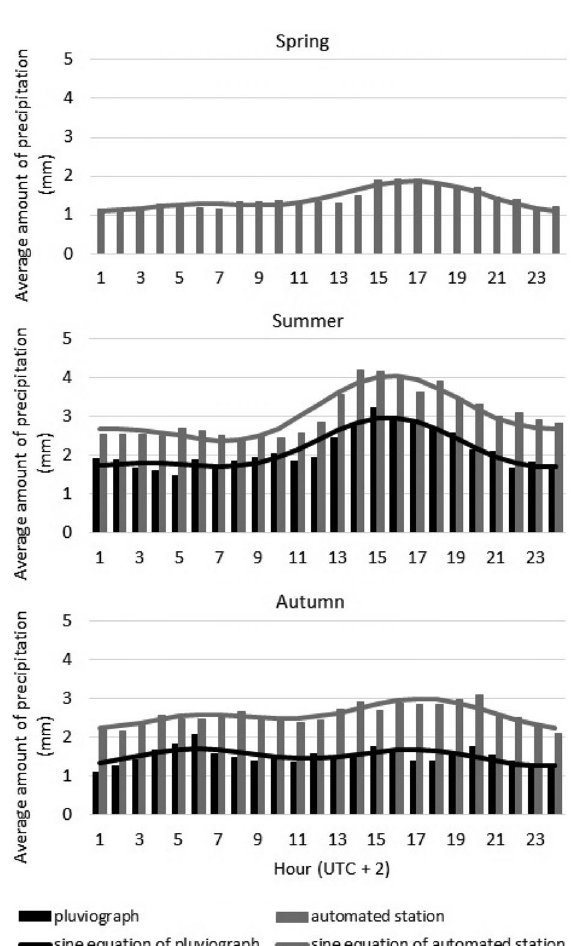
Fig. 3. Mean diurnal distribution of hourly precipitation amounts (mm) in Estonia by seasons in 2003–2013, calculated from the pluviographic records in 1991–2003 (black columns) and from the automated precipitation gauges in 2003–2013 (grey columns). Thick lines present the approximating diurnal curves of